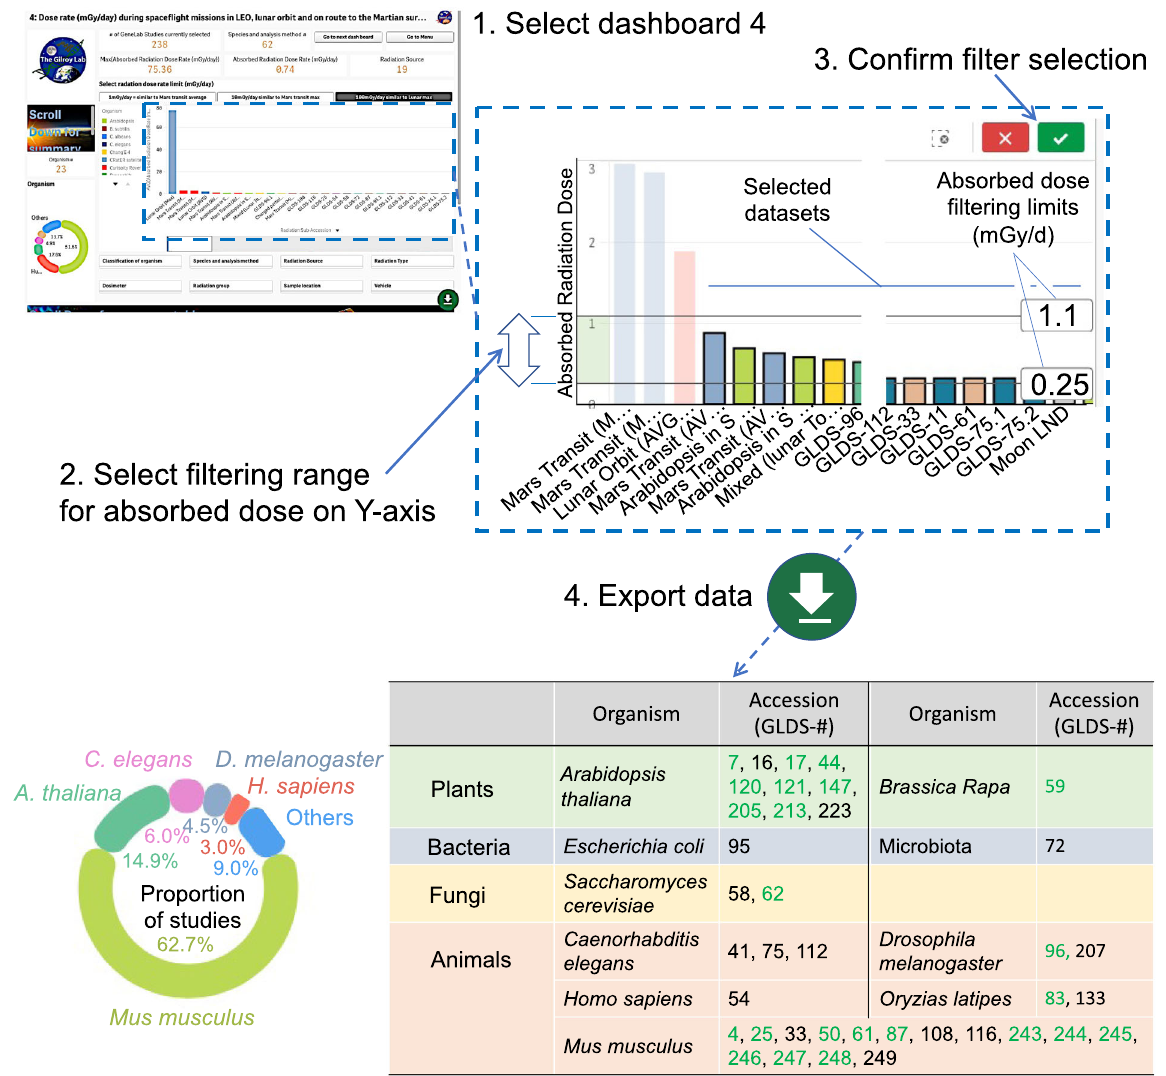
Fig. 5 Example of use of Rad-Bio-App to de fi ne datasets within the GeneLab data repository mimicking a lunar surface exposure. The data within dashboard #4 of the Rad-Bio-App contains radiation data from Martian, lunar and space fl ight missions and ground-based radiation experiments. These data were fi ltered using radiation levels recorded on the lunar surface by the Chang ’ e 4 lander, with limits set to span a 2-fold range around the average dose rate (0.55 mGy/d). Results of this fi ltering were then exported to build a listing of space fl ight experiment datasets within the GeneLab data repository where their radiation exposure lies within this range of dose rates. Green numbers in table, datasets pre-processed by either the GeneLab uniform microarray or RNAseq analysis